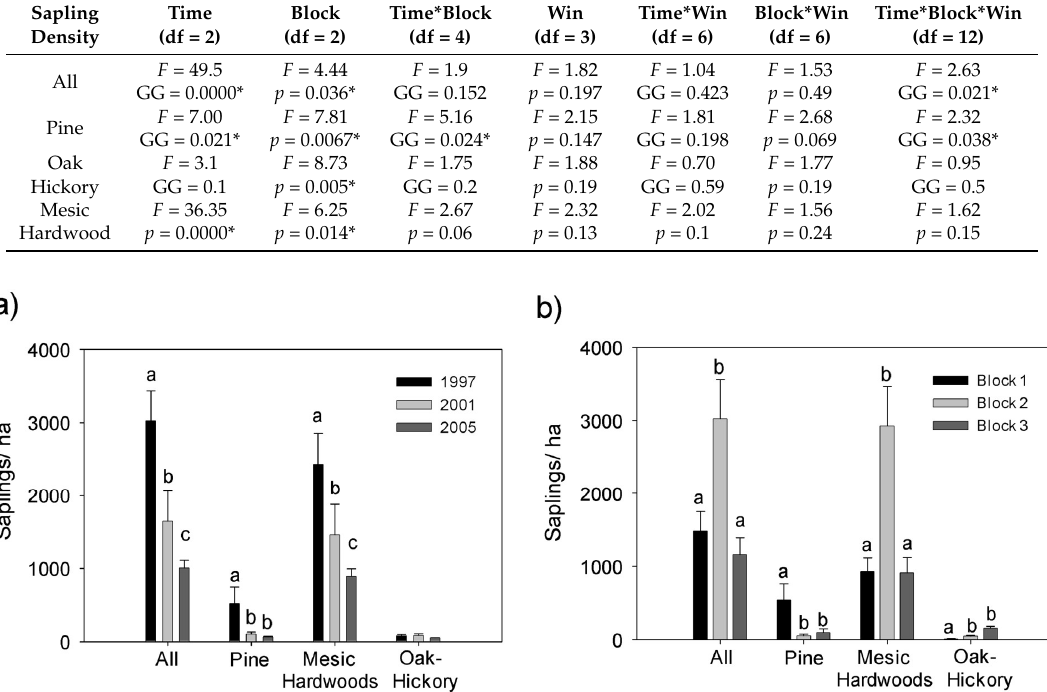
Figure 2. Effects of repeated growing season prescribed fire on density of saplings (0.25 to 11.6 cm dbh) ( a ) over time and ( b ) by block in mixed pine–hardwood forests of the Piedmont National Wildlife Refuge near Macon, Georgia, USA. Letters represent significant differences ( p ≤ 0.05) for post hoc Tukey’s Tests on the main effect of time between 1997, 2001, and 2005.